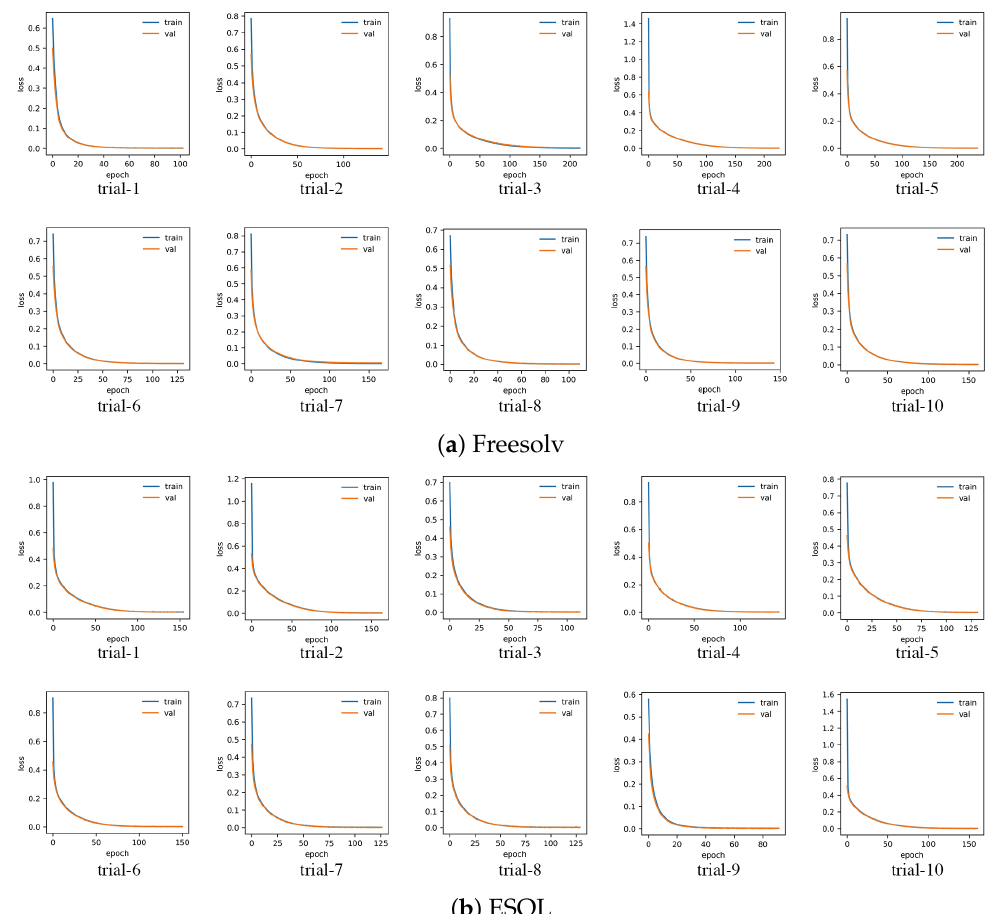
Figure 5. Loss curves of the proposed model.